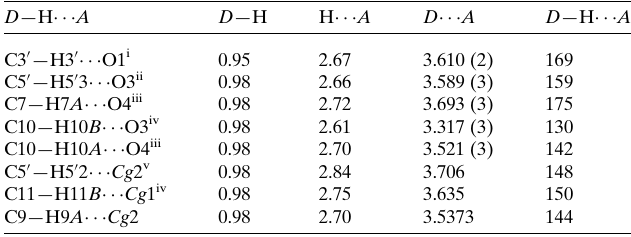
Table 1 Hydrogen-bond geometry (A˚ , (cid:3) ). Cg 1 and Cg 2 are the centroids of the phenyl rings C1–C6 and C1 0 –C6 0 , respectively. D —H (cid:2)(cid:2)(cid:2) A